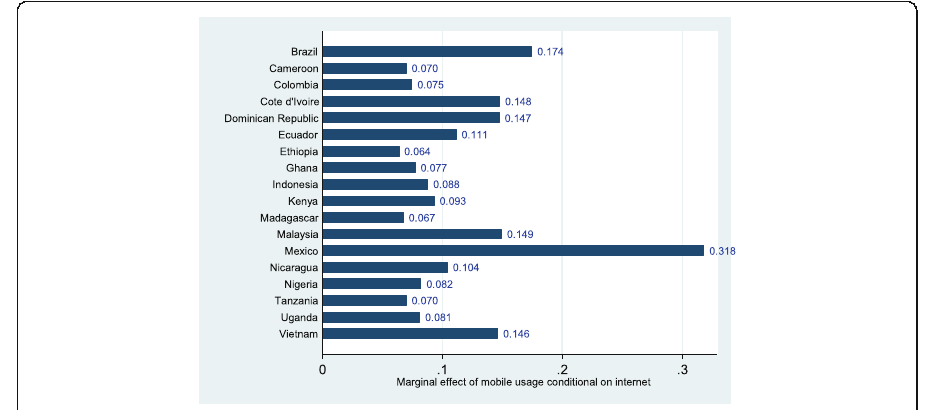
Fig. 5 Total effect of mobile phone usage on relative price margin across